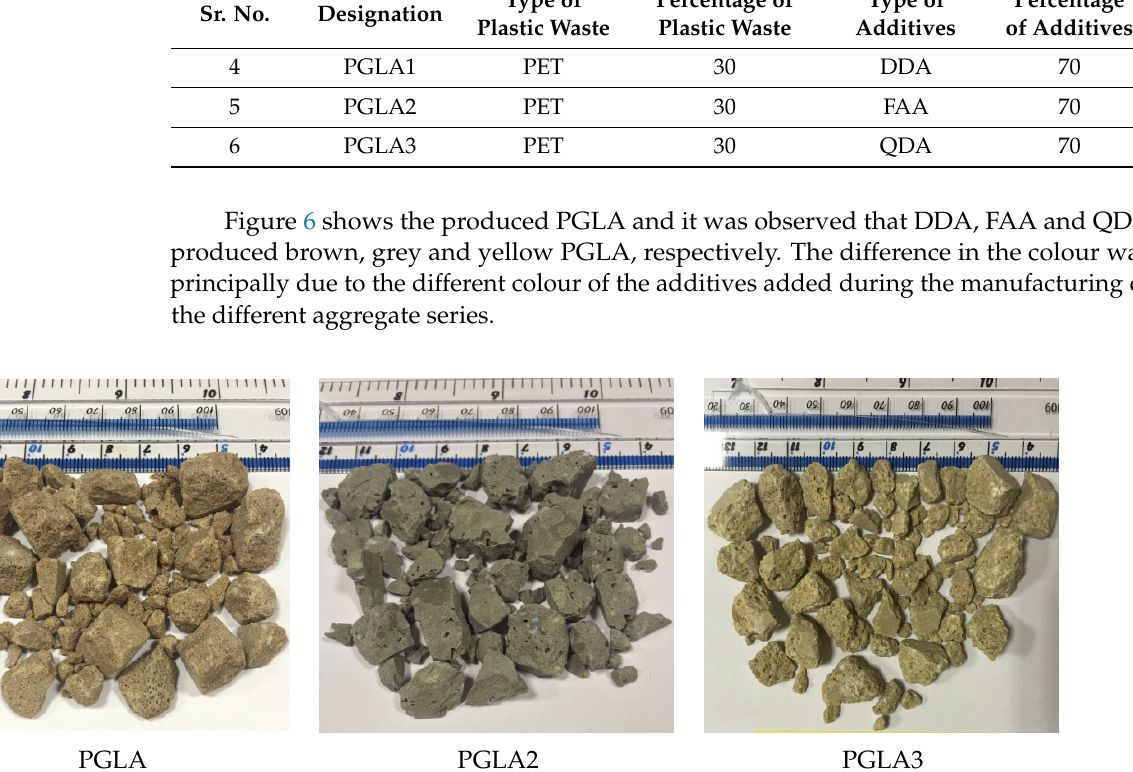
Table 5. Properties of the developed plastic based green lightweight aggregates (PGLAs) as compared to NCA, VLA and LYA.